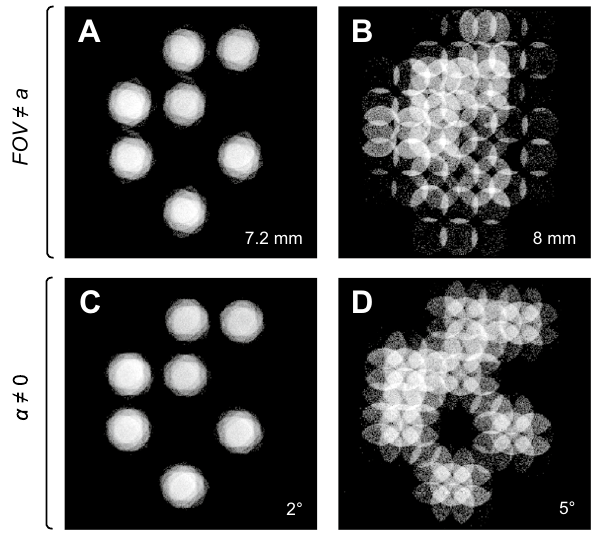
Figure 3. Sensitivity to imperfections in FOV and α. ( A , B ) Mismatch between the FOV and the unit cell size of the sample a and ( C , D ) misalignment between magnetic field gradient directions and symmetry axes of the sample measured by angle α . ( A , C ) The resulting images have small blurring when the discrepancies are small and ( B , D ) much higher blurring when FOV ( B ) and angle ( D ) are misadjusted to a more severe